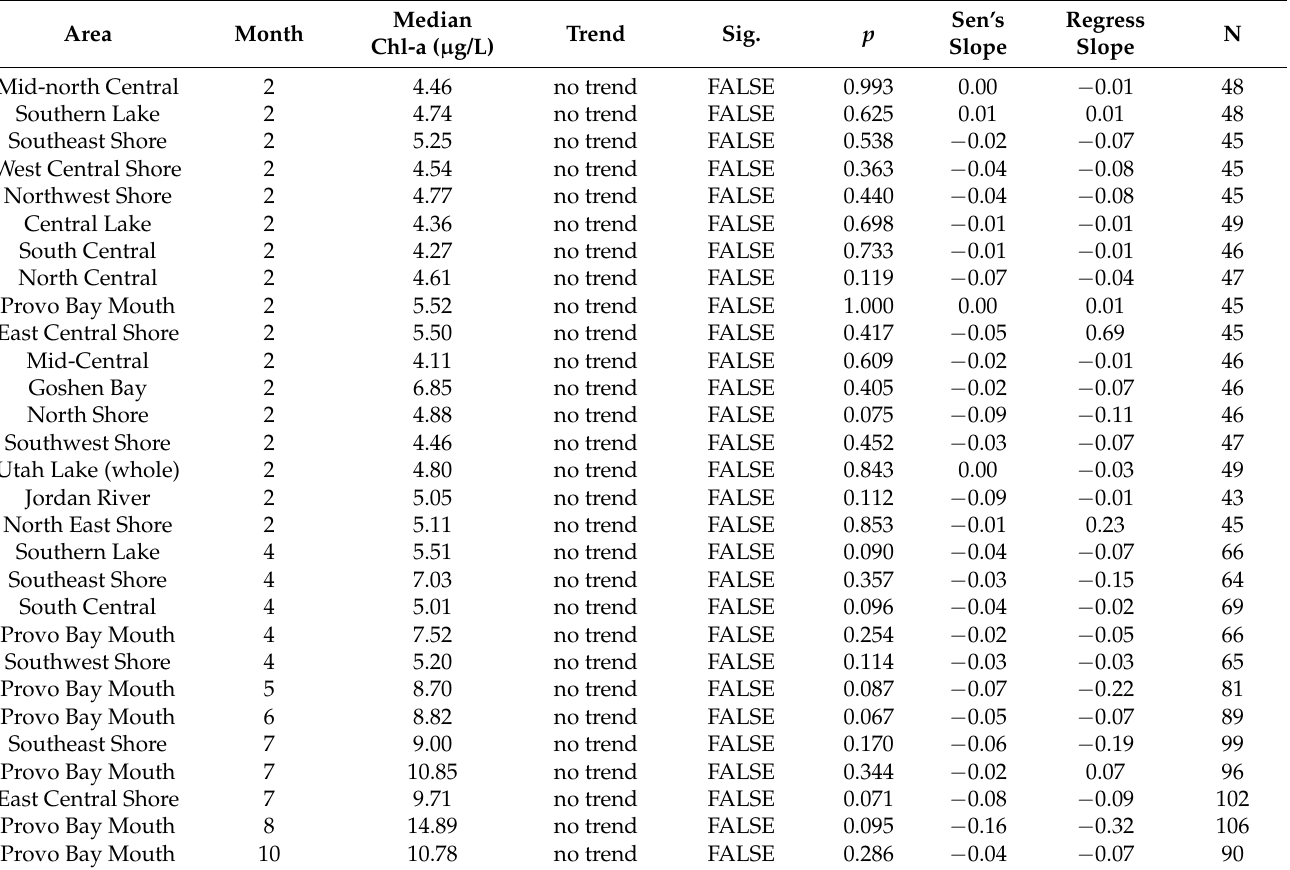
Table 5. Monthly trend analysis results for analysis areas without decreasing trends (excluding winter months and Provo Bay) sorted by p